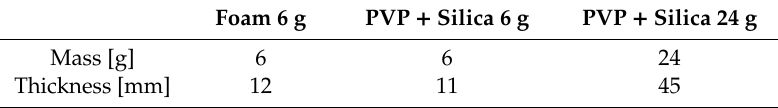
Figure 6. Absorbing coefficients for the considered materials. Table 1. Masses and thicknesses for each considered material.